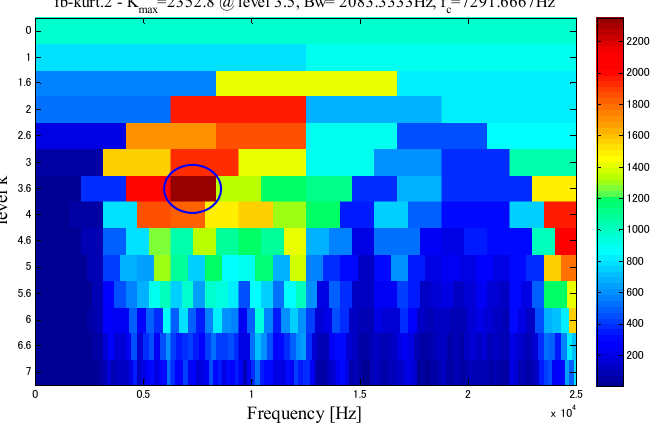
Figure 27. Fast Kurtogram.